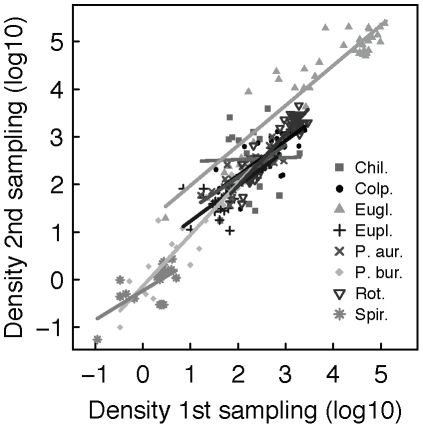
Population densities after 32 and 43 days.Species-specific linear correlations between the density in the first and second sampling, after 32 and 43 days respectively (density data log10-transformed; for statistics see also table 1). In all but one species (Chi), density at the second sampling was strongly correlated with density at the first sampling. Abbreviations of the species: Chil.  =  Chilomonas sp., Colp. Colpidium sp., Eupl.  =  Euplotes aediculatus, P. aur.  =  Paramecium aurelia, P. bur.  =  Paramecium bursaria, Rot.  =  rotifer, and Spir.  =  Spirostomum sp.